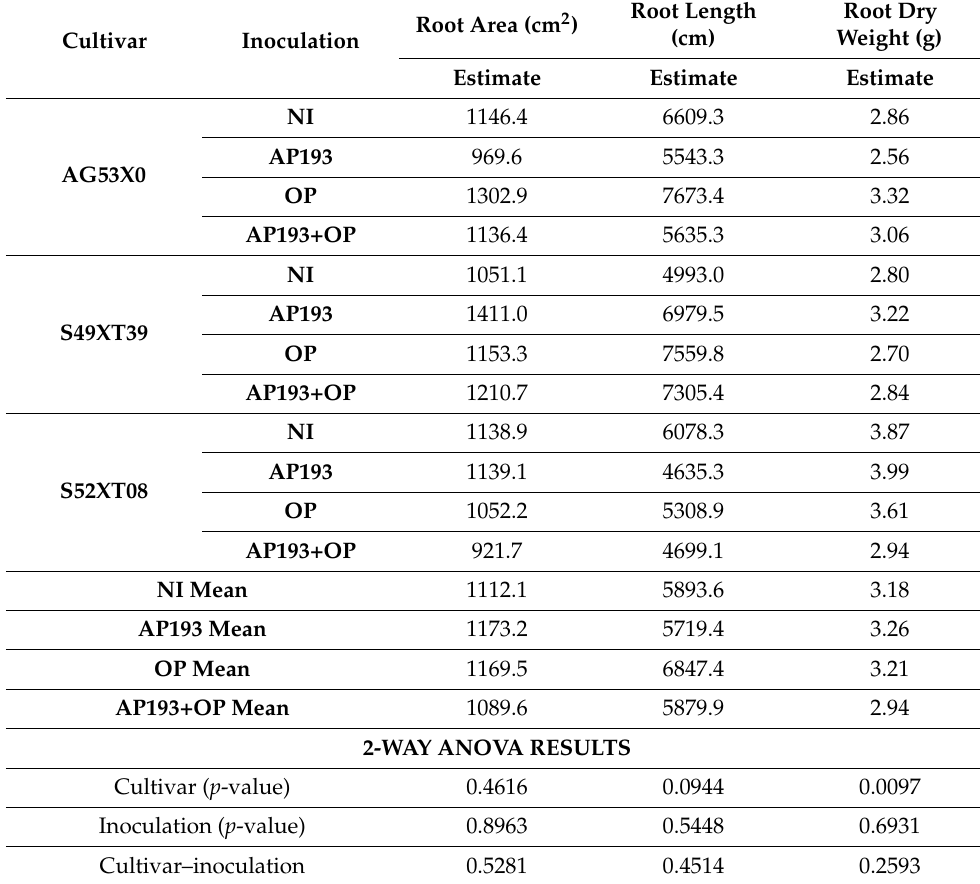
Table 6. Root area, root length and root dry weight of three soybean cultivars (AG53X0, S49XT39, S52XT08) inoculated with Bv AP193, OP the combination of Bv AP193 and OP, or the NI control and grown under greenhouse conditions. The bottom section of the table shows the ANOVA results ( p -value) for the effect of cultivar, inoculation, and the interaction cultivar–inoculation. Root Length Root Dry Root Area (cm 2 ) (cm) Cultivar Inoculation